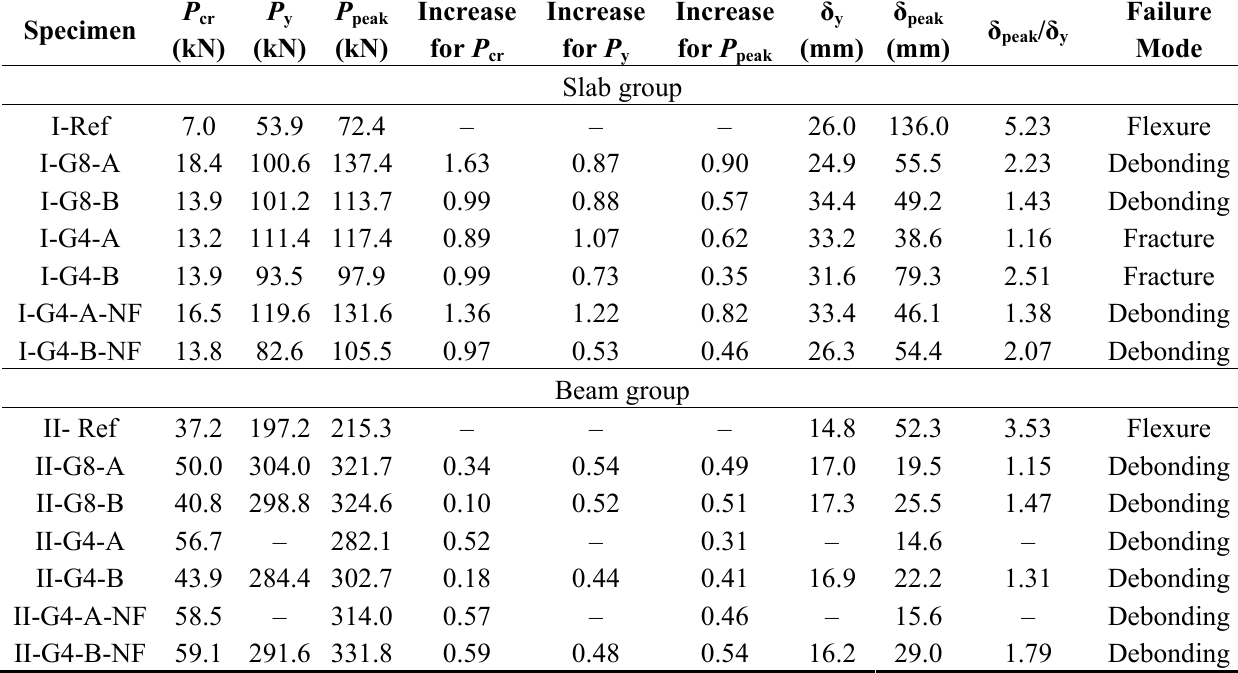
Table 4. Summary of test